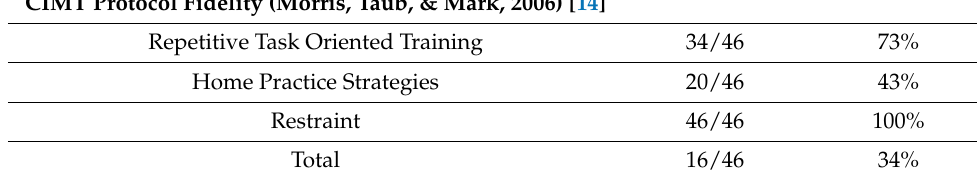
Table 2. Fidelity to the CIMT Protocol. CIMT Protocol Fidelity (Morris, Taub, & Mark, 2006) [14]